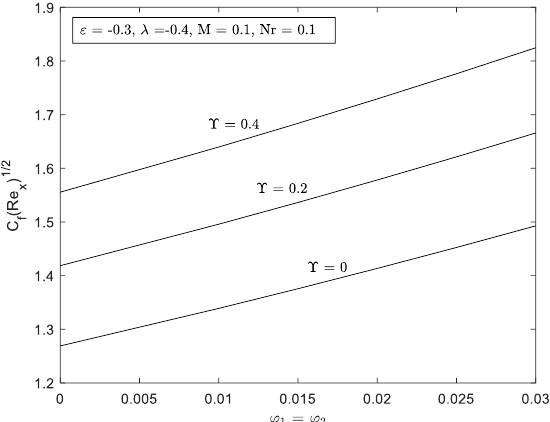
1 1 − 1 1 2 for several M with ϕ 1 = ϕ 2 . Figure 11. 𝑁𝑢 2 for several M with 𝜑 1 = 𝜑 2 . 2 for several M with 𝜑 1 = 𝜑 2 . 𝒙 (𝑅𝑒 𝒙 ) 2 for several M with 𝜑 1 = 𝜑 2 .